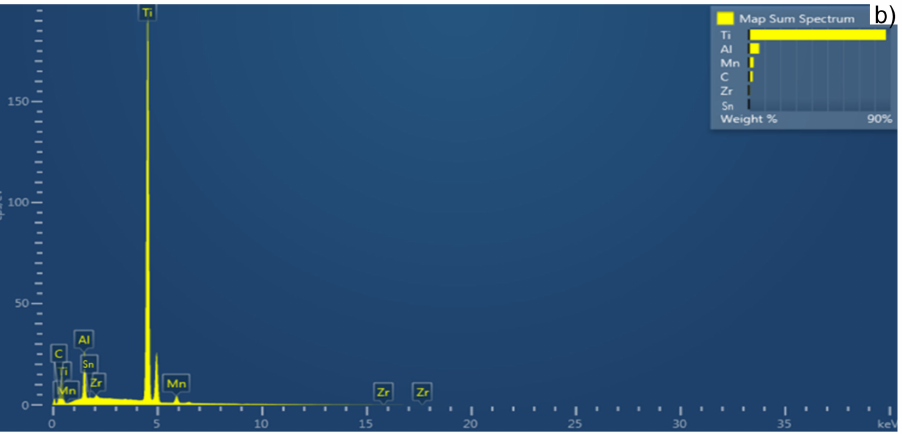
Figure 10. The X-ray diffraction (XRD) ( a ) and energy dispersive X-ray analysis EDX ( b ) for sample obtained by TSS.